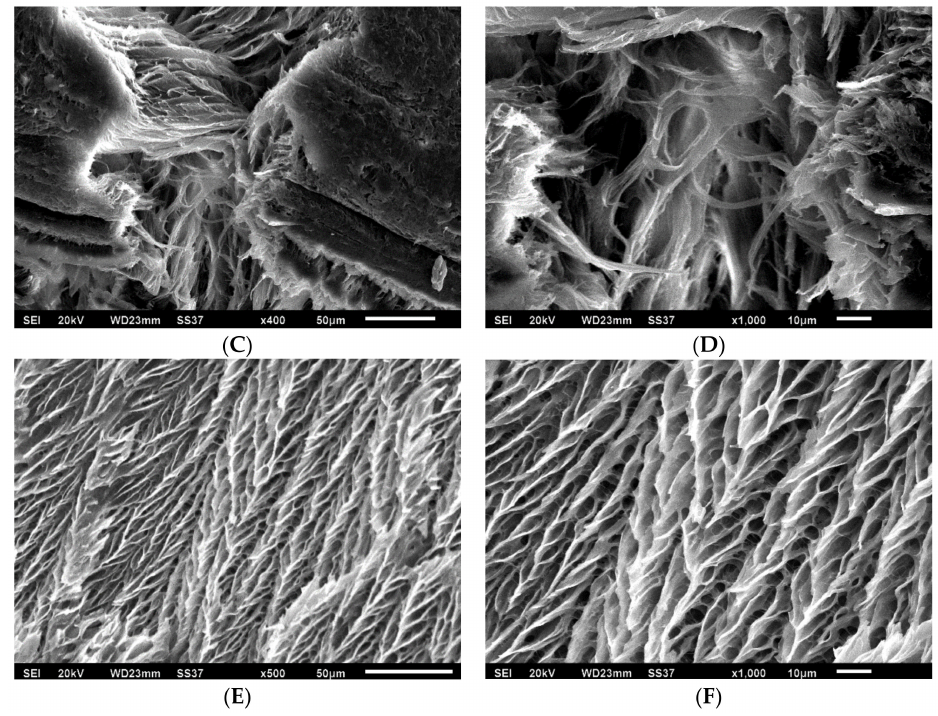
Figure 3. SEM images of aerogel samples. ( A , B ) P5; ( C , D ) P5/S, ( E , F )